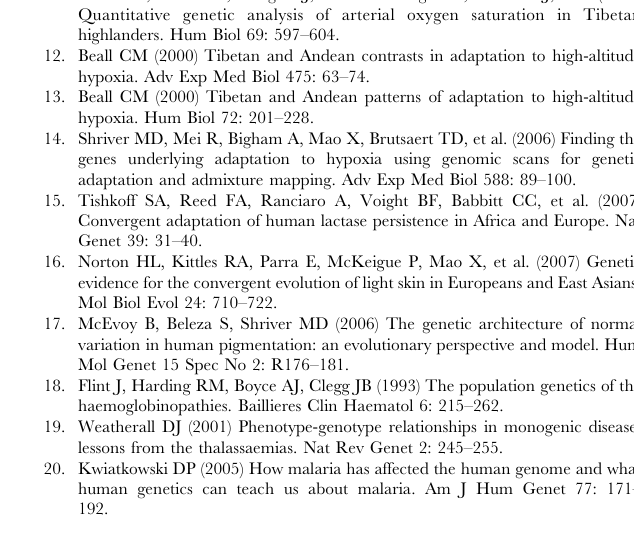
Figure S1 Indigenous American ancestry estimates. (A) The effect of admixture on PC plot with all 439,046 SNPs (B) Intermediate PC plot with 240,969 SNPs (threshold 0.9) showing how the gap with the European cluster is reduced. Final step, with threshold 0.8 is shown in Figure 2A (where Europeans (EUR) have been removed to simplify the graphical representation). Figure S2 Frappe clustering for values of K other than that presented in Figure 1C. Figure S3 Frappe clustering for values of K other than that presented in Figure 1D. Table S1 One megabase windows displaying extended regions of statistical significance calculated using the hypergeometric distribution for LSBL, ln RH , and the standardized difference of D . All windows listed are statistically significant for the standardized difference of D and LSBL or ln RH as indicated in column 2.